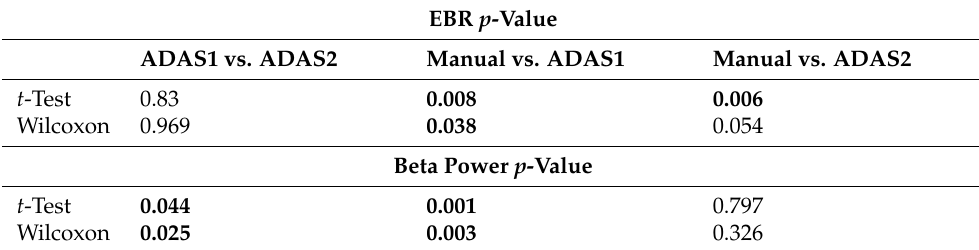
Table 2. Wilcoxon test and paired t -test